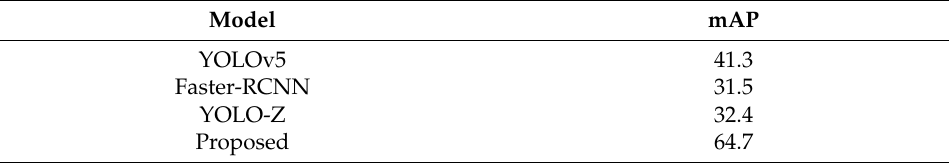
Table 3. Benchmarks on human detection task.